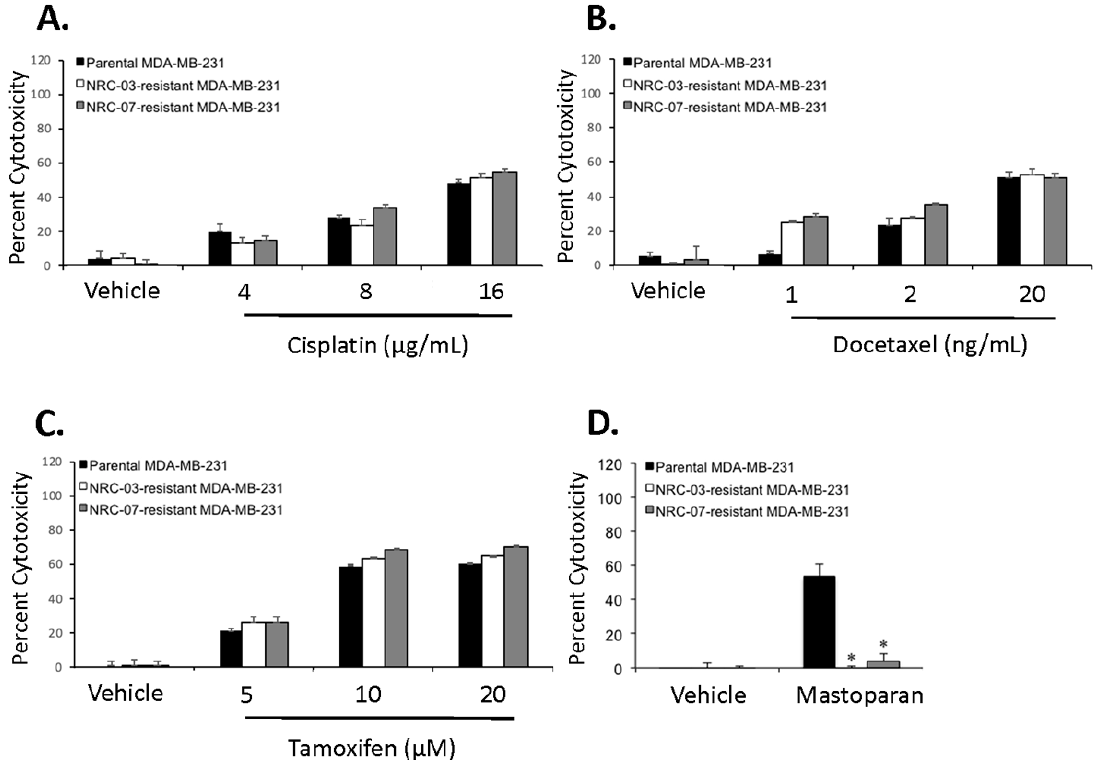
Figure 2. NRC-03-and NRC-07-resistant breast cancer cells are killed by cisplatin, docetaxel, and tamoxifen, but not mastoparan. Parental MDA-MB-231 cells, NRC-03-resistant MDA-MB-231 cells, and NRC-07-resistant MDA-MB-231 cells were cultured in the absence or presence of the indicated concentrations of ( A ) cisplatin, ( B ) docetaxel, ( C ) tamoxifen, or ( D ) mastoparan (25 μ M). Cell viability was determined by MTT assay after 24 h (mastoparan) or 72 h (cisplatin, docetaxel, and tamoxifen). PBS was the vehicle for cisplatin and mastoparan, and dimethyl sulfoxide (< 0.01%) was the vehicle for docetaxel and tamoxifen. Data shown represent the mean of technical replicates ± standard deviation and are representative of 2–3 independent experiments. Statistical significance, in comparison to parental MDA-MB-231 cells, was determined by the Bonferroni multiple comparisons test (* p < 0.0005).